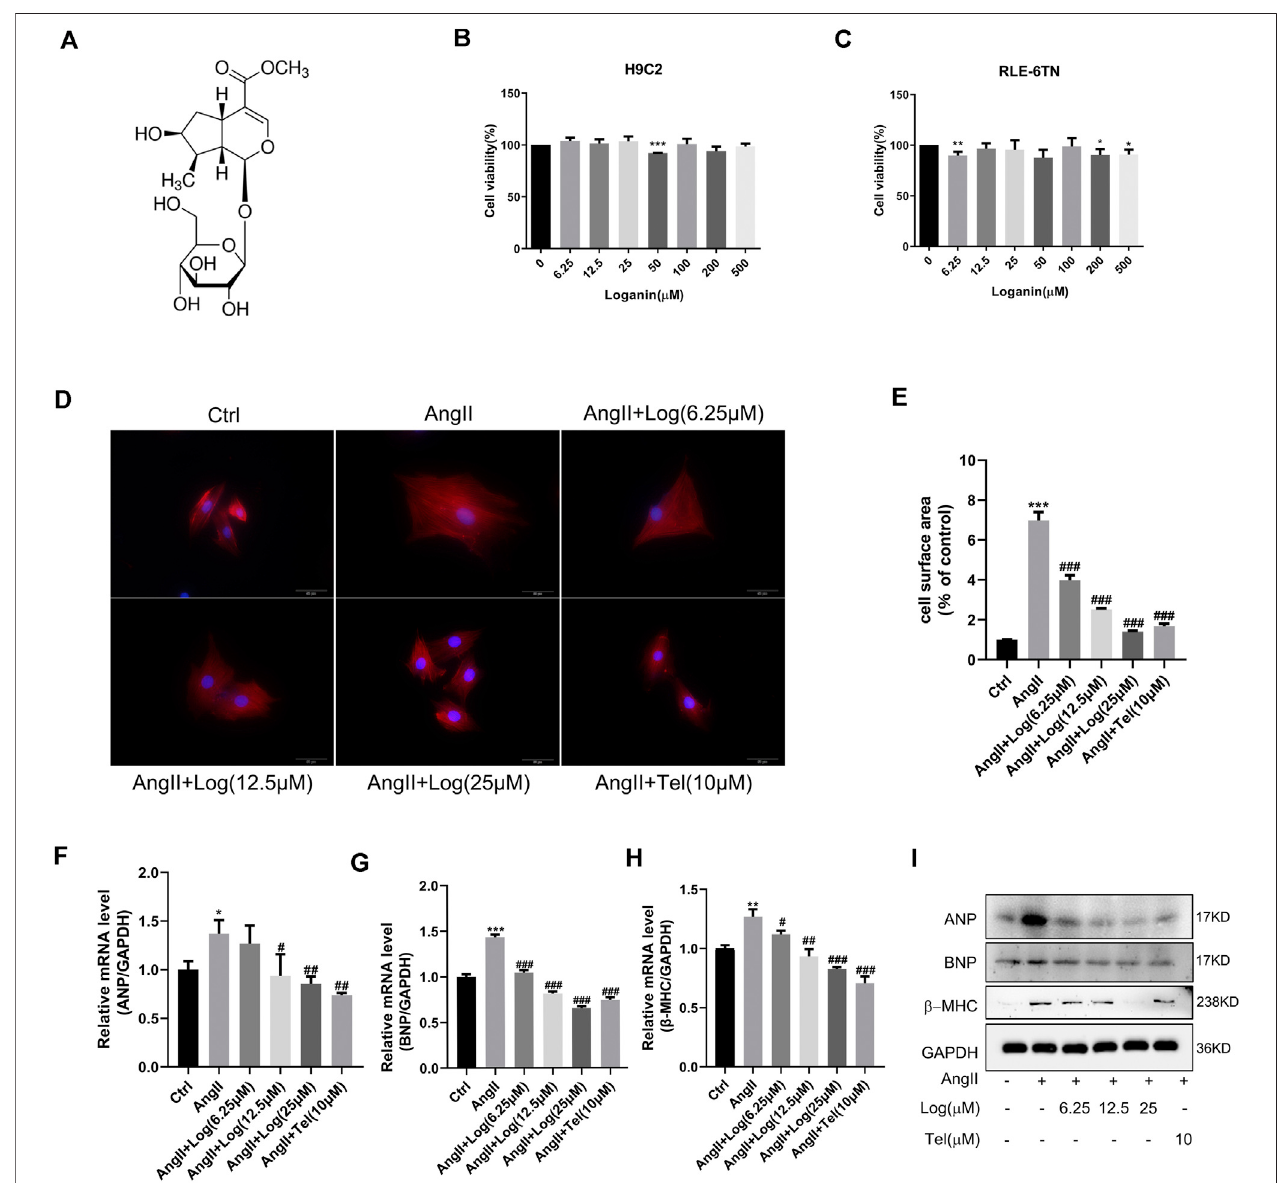
FIGURE1| LoganinattenuatescardiomyocytehypertrophyinducedbyAngII invitro. (A) Molecularstructureofloganin. (B,C) H9C2andRLE-6TNcellsaretreated withdifferentconcentrationsofloganin(0 – 500 μ M)for24 h.Thecellviabilitiesaremeasured byMTTassay( n (cid:2) 3). (D) H9C2 cellsarestainedwith α -actin (red)and DAPI (blue) to detect the size of cells, and immuno fl uorescence images are captured by fl uorescence microscopy. Scale bars (cid:2) 50 µm. (E) Statistical quantitative analysis of the area of H9C2 cells by ImageJ software ( n (cid:2) 3). (F – H) Loganin suppressed the mRNA expression levels of Ang II – induced hypertrophic markers, namely, ANP, BNP, and β -MHC, using RT-PCR analysis ( n (cid:2) 3). (I) Relative expression of ANP, BNP, and β -MHC proteins in the Ang II – treated H9C2 cells with or without loganin incubation. Dataareexpressed asmean ± SD. * p < 0.05, ** p < 0.01, *** p < 0.001 vsthe control group; # p < 0.05, ## p < 0.01, ### p < 0.001 vs theAng II – treated group (analyzed using one-way ANOVA). Telmisartan (Tel) is a positive control group.